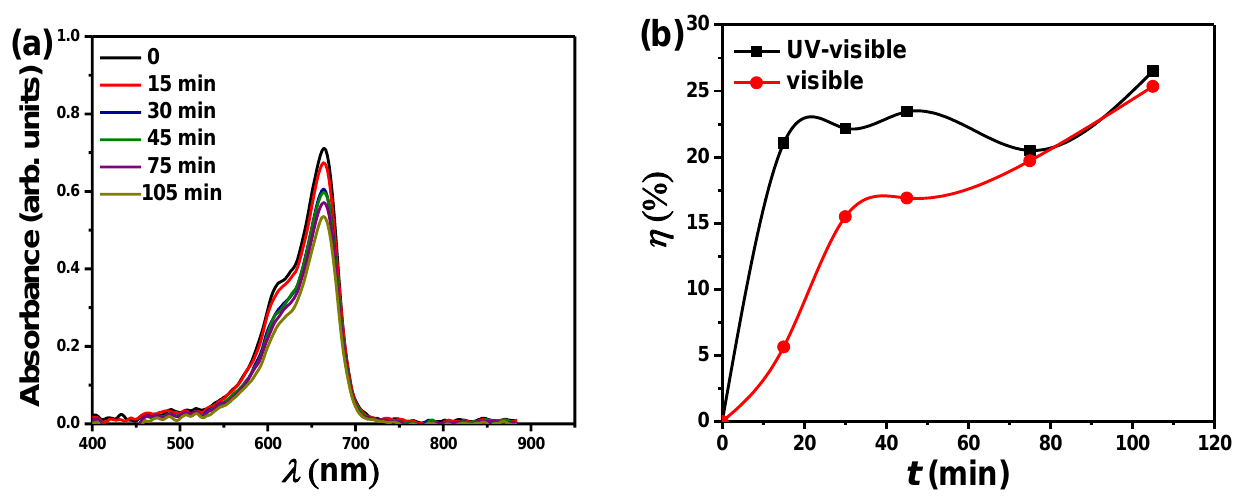
Figure 10. ( a ) The optical absorption spectrum of MB as a function of wavelength ( λ ) after photore- duction of the MB in the presence of PbO-40% Al 2 O 3 as a catalyst for various times. ( b ) the plot compares photocatalytic efficiency ( η ) at different irradiation times under UV-visible light or visible light using PbO-40% Al 2 O 3 as a catalyst.